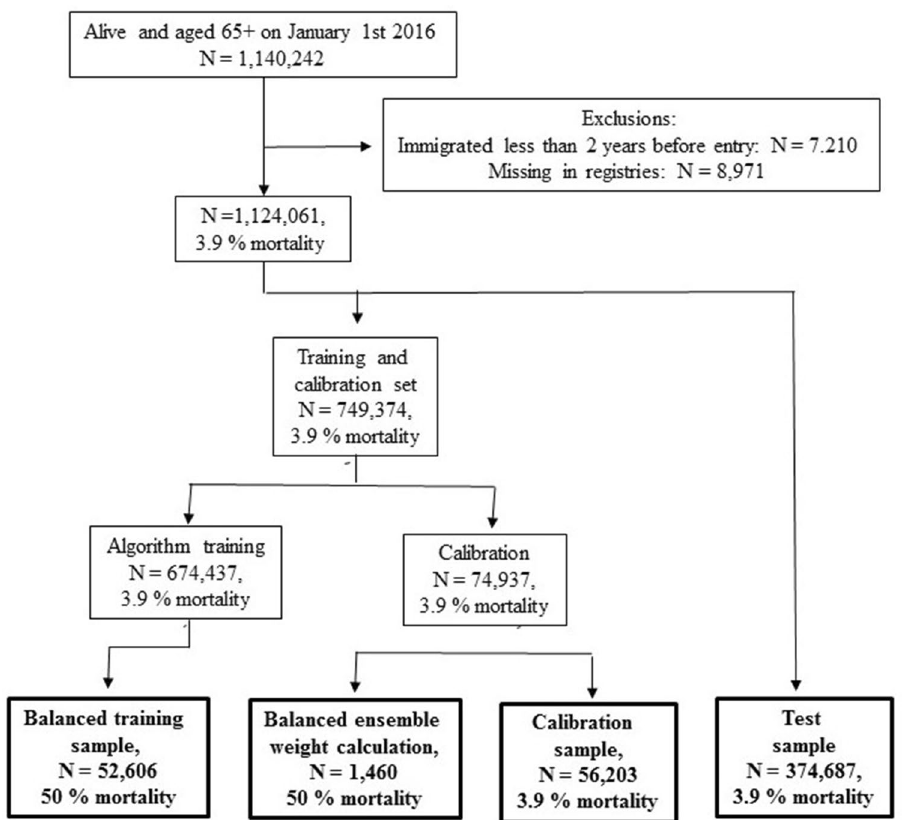
Figure 1. Chart describing inclusion in the study population, and data flow into the prediction algorithm. Individuals were included in the national population study if they were alive and aged 65 + on January 1st 2016 and had been living in Denmark for two years prior to this baseline date. A random sample of two thirds was selected, and a prediction model was trained on this sample, predicting individual-level mortality risk in the year after baseline based on characteristics observed during the two years before baseline. The prediction model was then used to predict one-year mortality risk for the remaining test sample, and this sample was followed up for mortality and healthcare expenditure for up to one year after